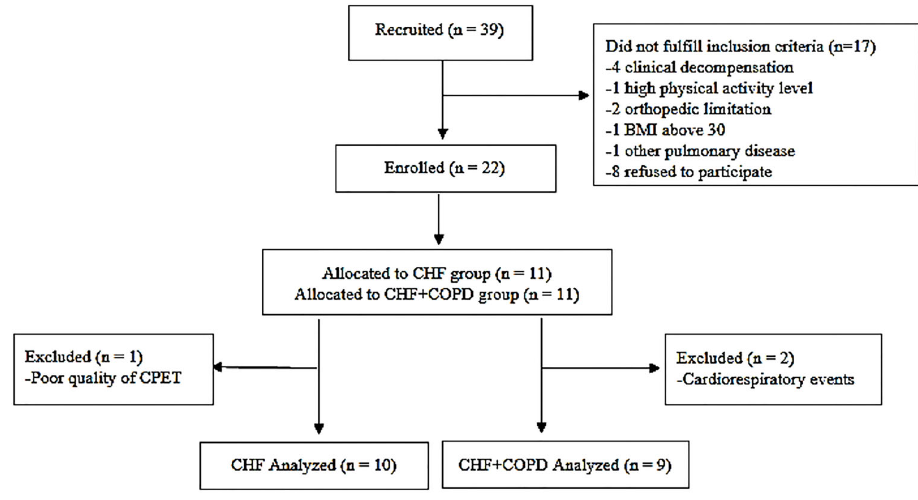
Figure 1. Flowchart of the study. COPD: chronic obstructive pulmonary disease; CHF: chronic heart failure.